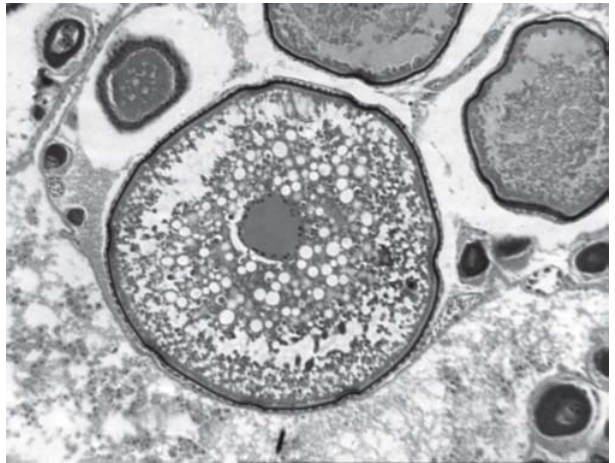
Fig. 6. Merluccius hubbsi: oocyte with complete vitellogen- esis (1.5mm length field).